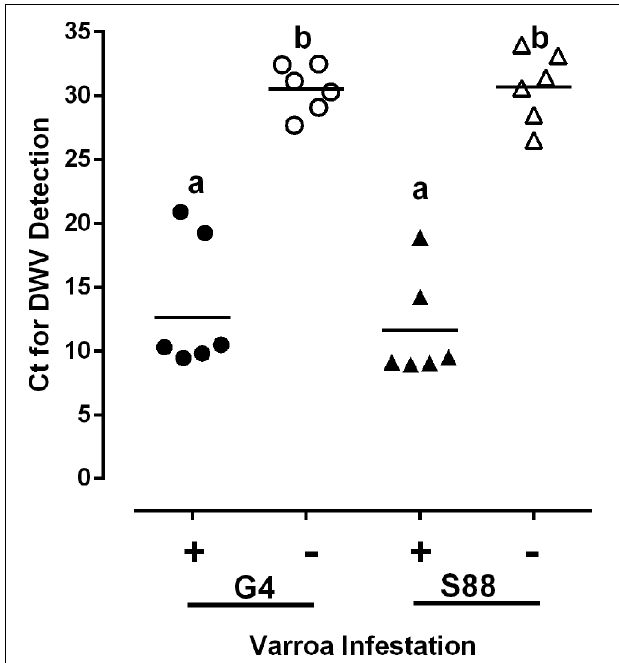
FIGURE 5 | Virus presence in honeybee populations. The level of deformed wing virus (DWV) present in dark-eyed pupae was compared in the presence ( + ) or absence ( − ) of a detectable Varroa mite infestation. DWV was detected using qRT-PCR and the level of viral infection was measured as the threshold cycle (Ct) for viral RNA amplification. Ct values are inversely proportional to the abundance of viral RNA. Data presented are values for individual pupae ( n = 6/group). Significant differences ( P -value < 0 . 05) among treatment groups are denoted by different letters above each column.